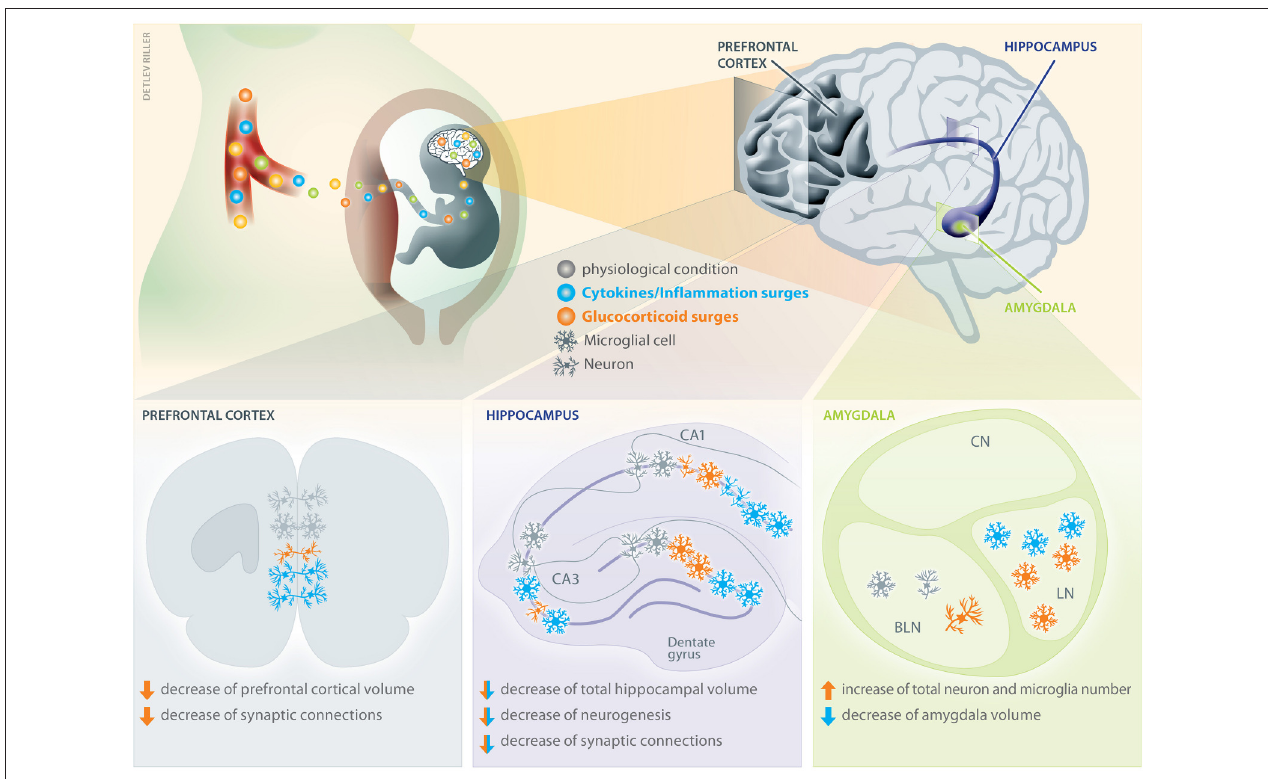
FIGURE 2 | Consequences of cytokine and glucocorticoid surges on distinct areas of the offspring’s brain. Maternal cytokines and glucocorticoids can transplacentally cross into the fetus and differentially affect offspring’s brain development by interfering with e.g., cell differentiation, axonal growth, and synaptic connectivity. The brain regions depicted here are of pivotal relevance for mental health due to their involvement in cognitive functions. Compared to physiological conditions, prenatal surges of maternal cytokines increase the number of neuronal connections in a subdivision of the prefrontal cortex, whereas glucocorticoids decreases them (105, 119). Additionally, prenatal glucocorticoid exposure decreases prefrontal cortical volume. In the hippocampus, an increase of cytokines is known to increase the number of microglial cells in the corn ammonis area 1 (CA1), whilst simultaneously reducing dendritic arborizations and neuronal complexity (111). Similarly, in the CA3 and dentate gyrus (DG) of the hippocampus, the microglia density increases after cytokine exposure. Also glucocorticoid surges deteriorate the neuronal complexity in CA1 and CA3 (109, 110) and have been shown to increases the number of microglia in DG. Both, cytokines and glucocorticoids can decrease total hippocampal volume, neurogenesis and synaptic connections. Prenatal cytokine surges can also decrease the amygdala volume, whereas glucocorticoids have been shown to increase the number of neurons and microglia. There is no evidence that the central nucleus (CN) of the amygdala is affected, but an increased microglia density after prenatal cytokine and glucocorticoid exposure has been detected in the lateral nucleus (LN) (120, 121). Contrarily, an increased number of neuronal connections and microglia was detectable upon glucocorticoid challenge in the basolateral nucleus